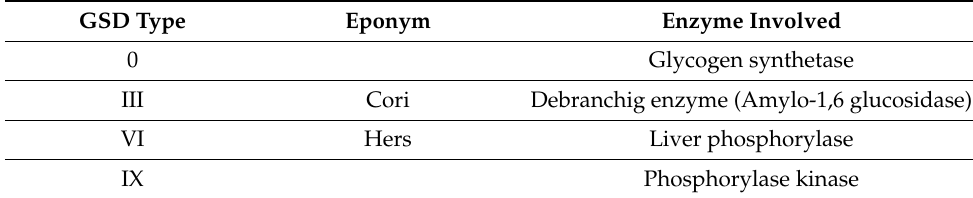
Table 4. Enzymes involved in ketogenic glycogen storage